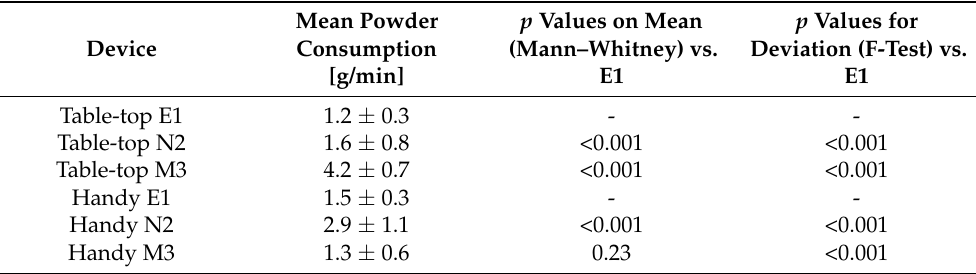
Table 3. Powder consumption and the standard deviation during one single pedal press: the statistical difference is compared between Table-Top E1 for Table-tops and Handy E1 for Handies.